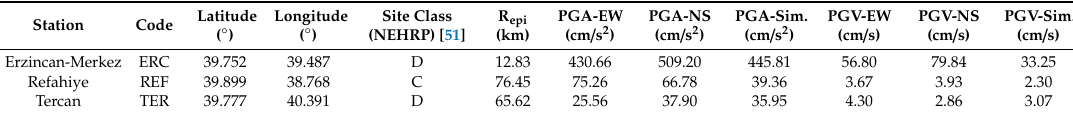
Figure 1. Selected stations along with the epicenter of the 1992 Erzincan event where the rectangular box shows the fault projection. Table 1. Information on the selected stations corresponding to the 1992 Erzincan (Turkey) event with Mw = 6.6.